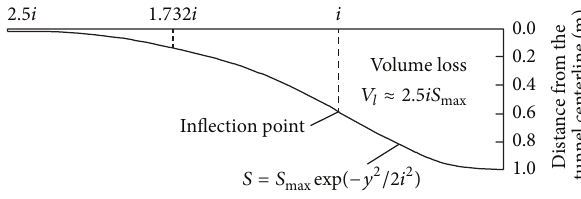
Figure 20: Transverse surface settlement trough curve.